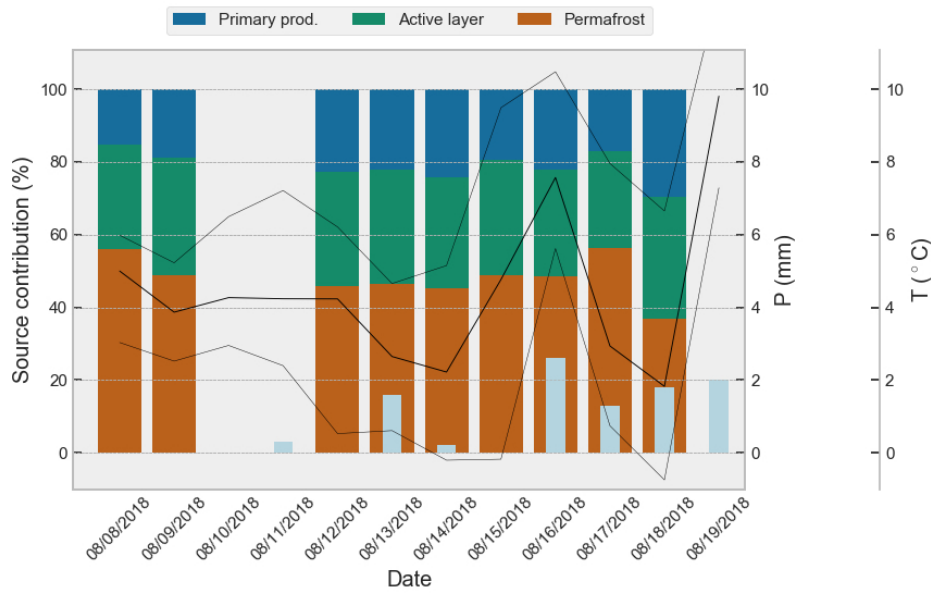
Figure 8. Modeled DOM source contributions, aggregated by day, to the catchment outlet sample over time. Plotted together with recorded rainfall (precipitation, P , light-blue bars) and recorded minimum, maximum and mean air temperature ( T , black lines). Please note that the date format used in this figure is